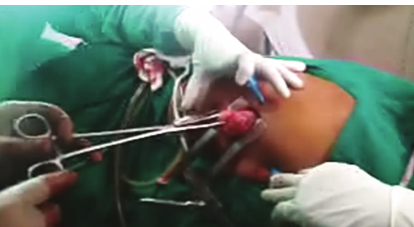
Figure 5: Specimen of esophageal leiomyoma being retrieved by enlarging camera port